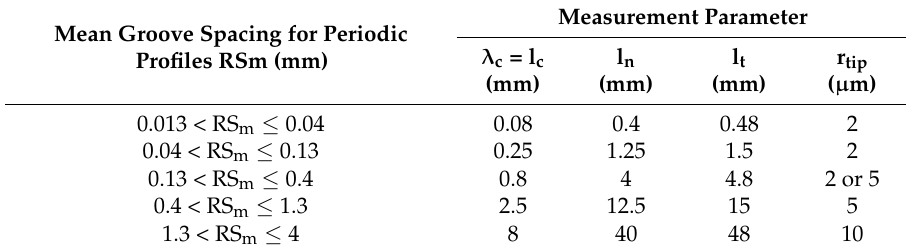
Table 6. Setup for the roughness measurement (EN ISO 4288).